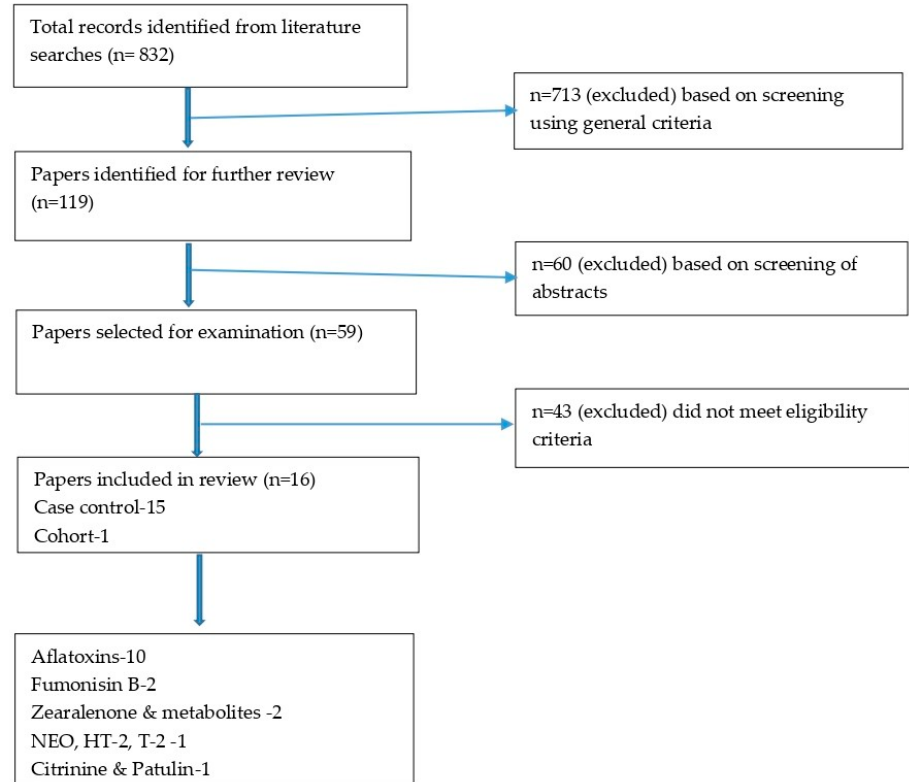
Figure 1. PRISMA chart for studies on mycotoxin-linked mutations and cancer risk.